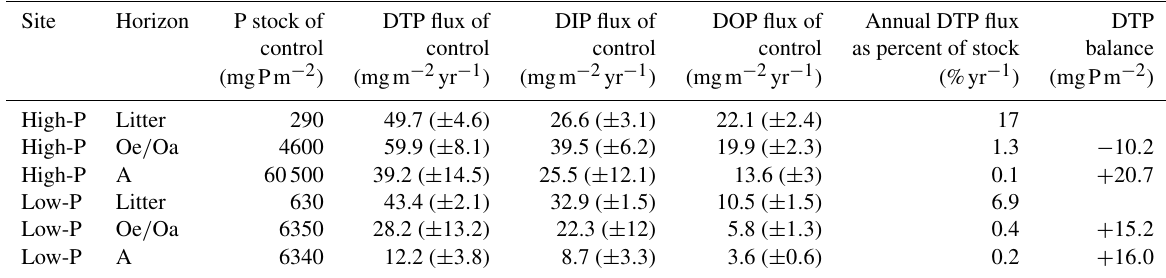
Table 3. Comparison of dissolved organic, inorganic, and total phosphorus fluxes (DOP, DIP, DTP) from litter, Oe / Oa, and A horizons with respective stocks (average of three field replicates taken in July 2019) of each horizon at the high-P site and the low-P site. Balances: the difference between the fluxes into and out of a given horizon; positive values reflect net accumulations and negative values net losses. Data from unfertilized plots ( n = 3). Means ± standard error (SE). Data for dissolved organic carbon can be found in Sect. S6.